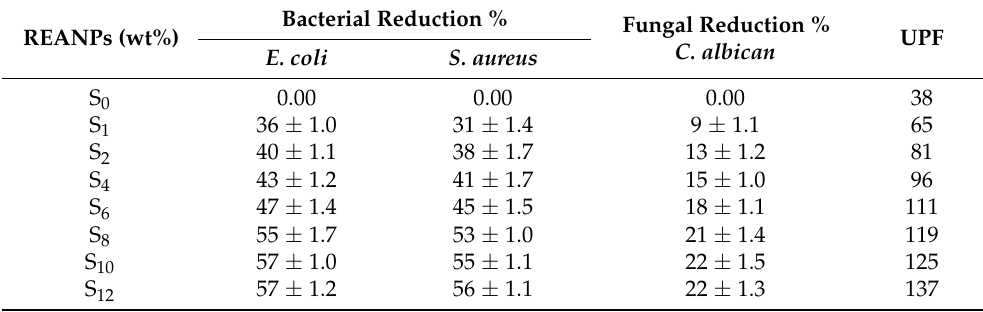
Table 6. Antimicrobial and UV-protection of pristine and sprayed cellulosic fabrics. Table 6. A ntimicrobial and UV-protection of pristine and sprayed cellulosic fabrics. REANPs